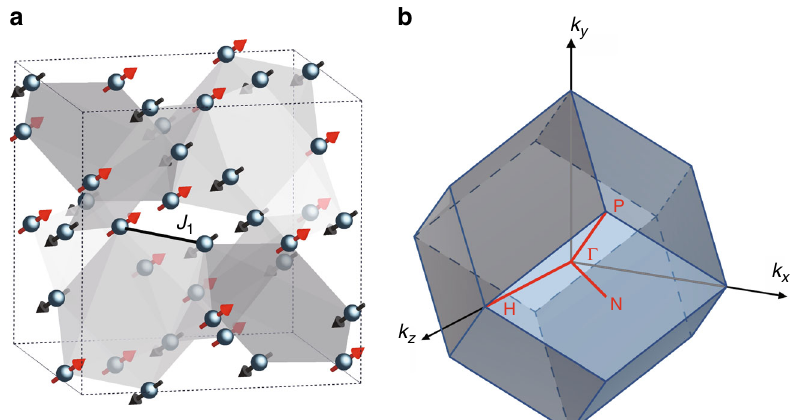
Fig. 1 Crystal structure and the fi rst Brillouin zone for Cu 3 TeO 6 . a Schematic for the centro-symmetric cubic crystal structure with the Ia -3 space group (no. 206). For simplicity, only Cu 2 + ions with spins indicated by arrows are shown. Shades indicate hexagons formed by Cu 2 + ions. The nearest-neighbour exchange interaction J 1 is indicated by a solid line. b The fi rst Brillouin zone of the primitive unit cell with high-symmetry paths and